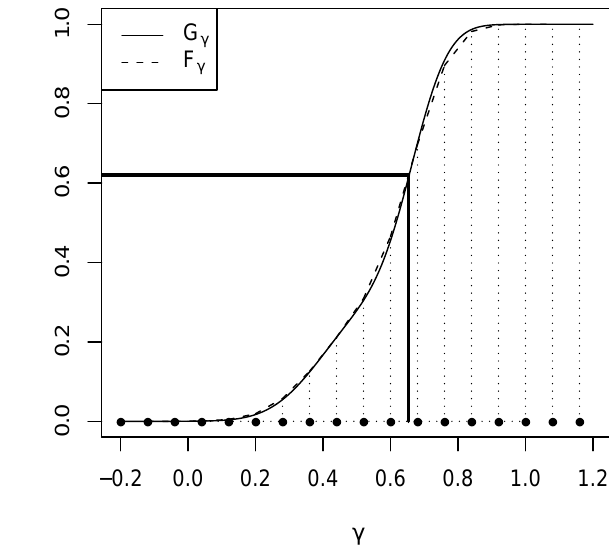
of the cdf G can γ γ